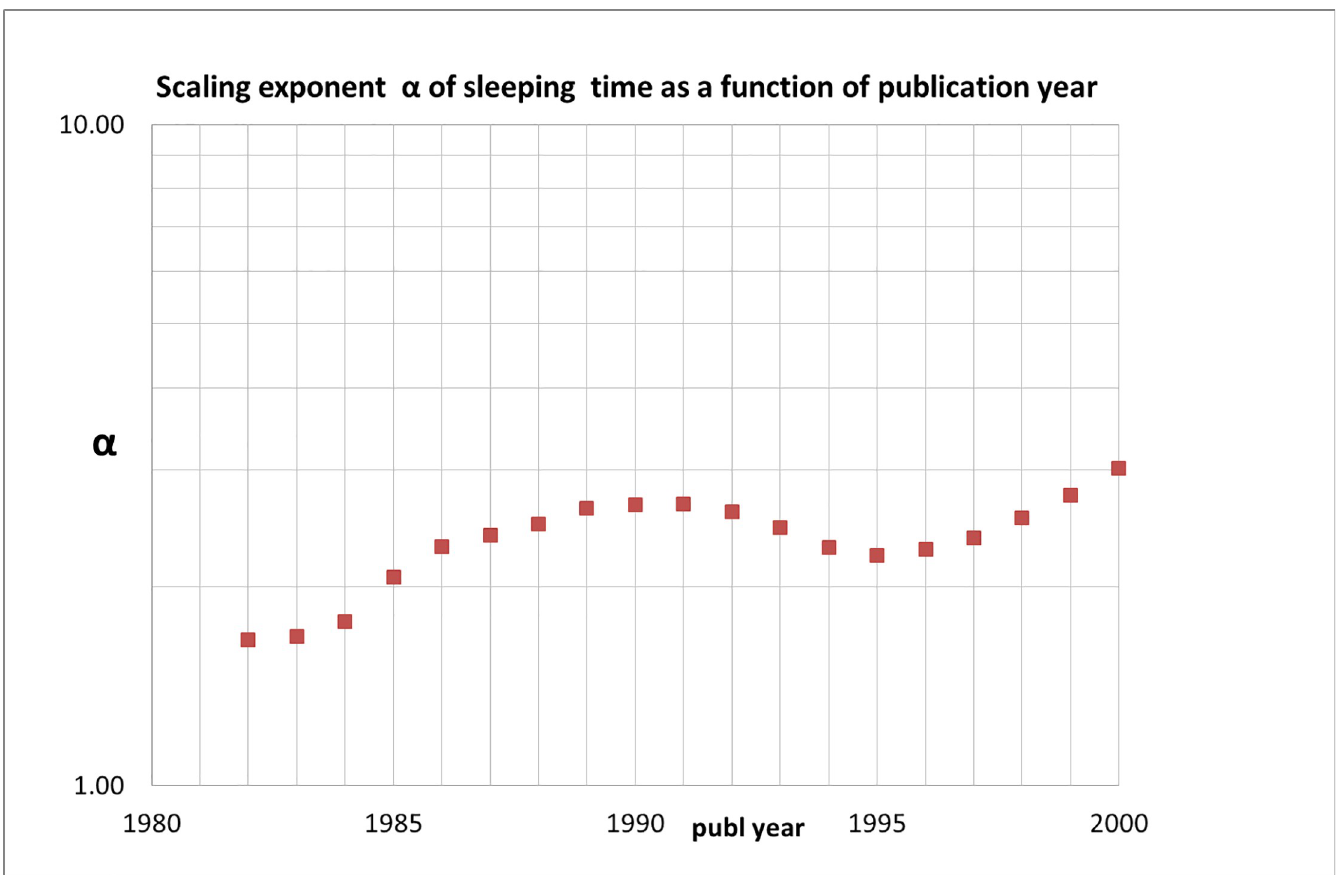
Fig 7. Scaling exponent α for the whole measuring period 1980–2000 as a function of publication year; numbers are the averages of successive five-years blocks, each five-years block is located in the figure by its middle year (because of the logarithmic scale we take the absolute values of α ).